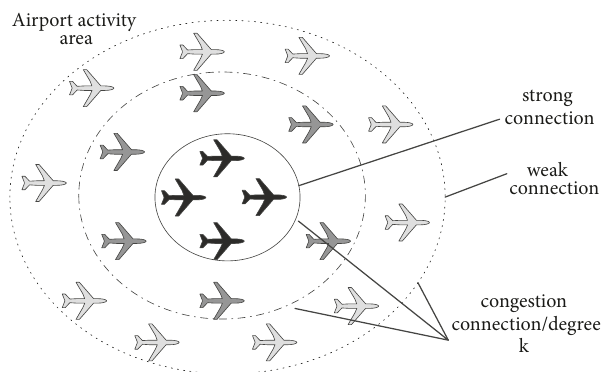
Figure 4: Congestion connection between departure flights in the airport activity